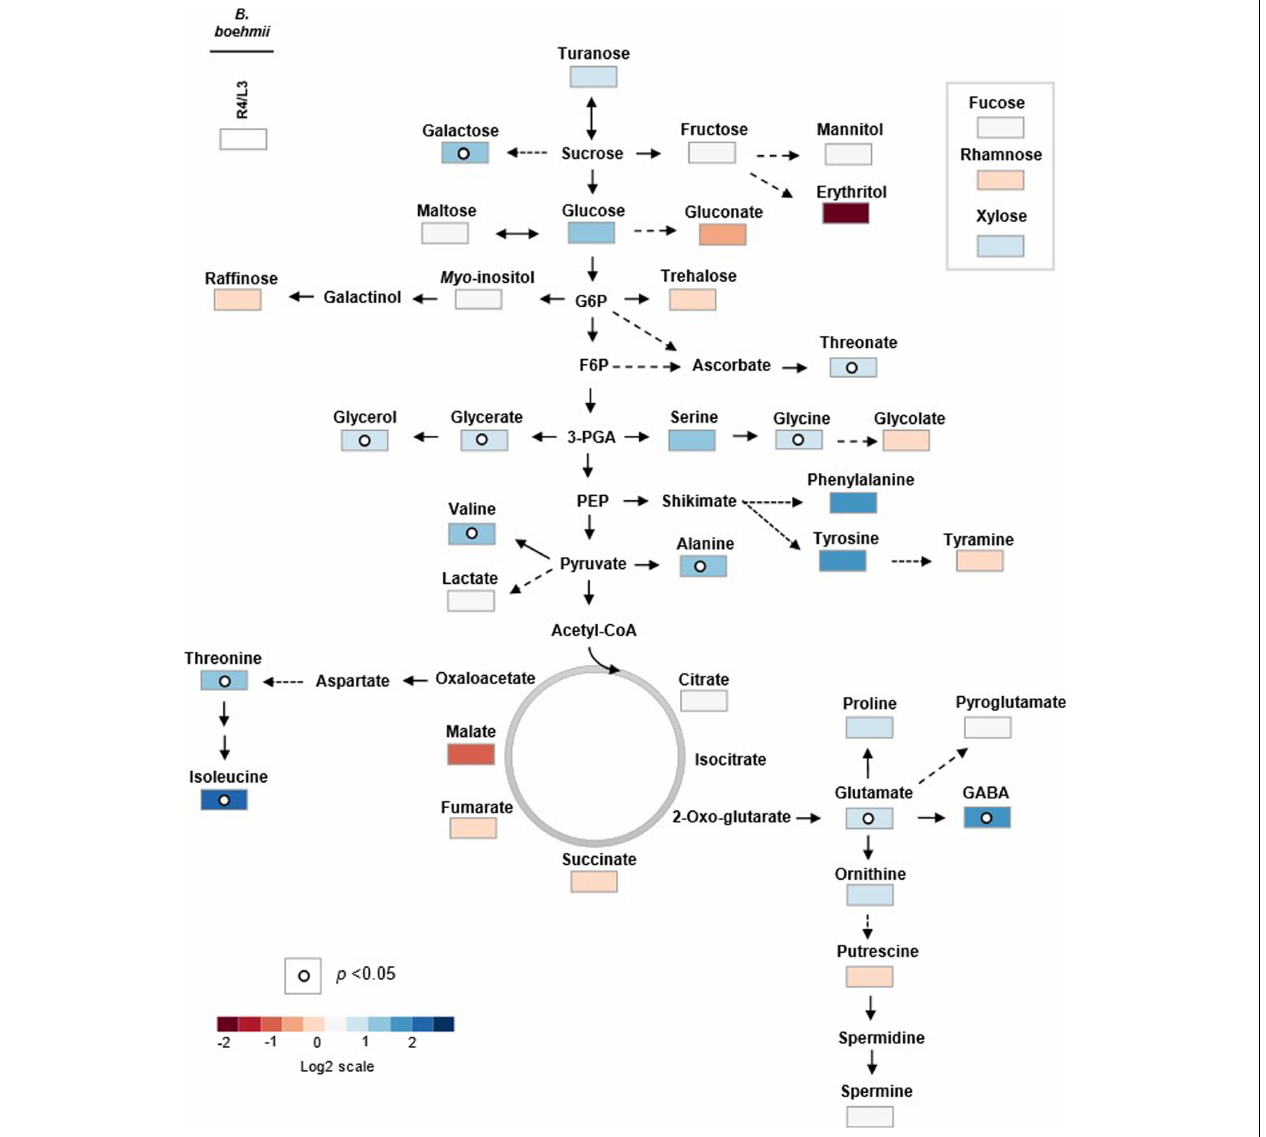
FIGURE 4 | Primary metabolic pathway reflecting the metabolite changes in B. boehmii under low fire frequency (L3) and high fire frequency (R4). The relative values are represented by log2 of the ratio between R4/L3 ± SE of ten accessions. Relative values were normalized to the internal standard (ribitol) and dry weight (DW) of the samples. Dots indicate that the differences are statistically significant by Student’s t -test ( p <